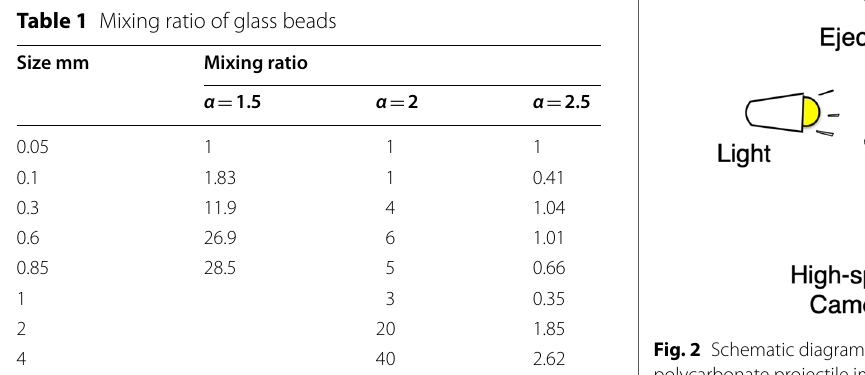
Fig. 2 Schematic diagram of the experimental setup. A polycarbonate projectile impacted perpendicularly to the target surface from the top in a vacuum chamber. Two-lights and high-speed camera were set outside the